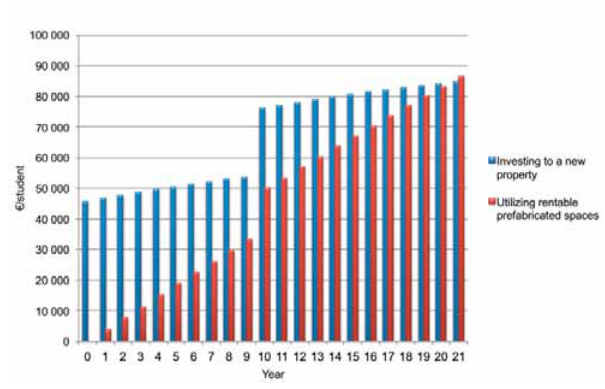
fig. 5. The cumulative discounted cots of the two investment alternatives when there is a decrease of 100 pupils (from 350 to 250) ten years after the initial